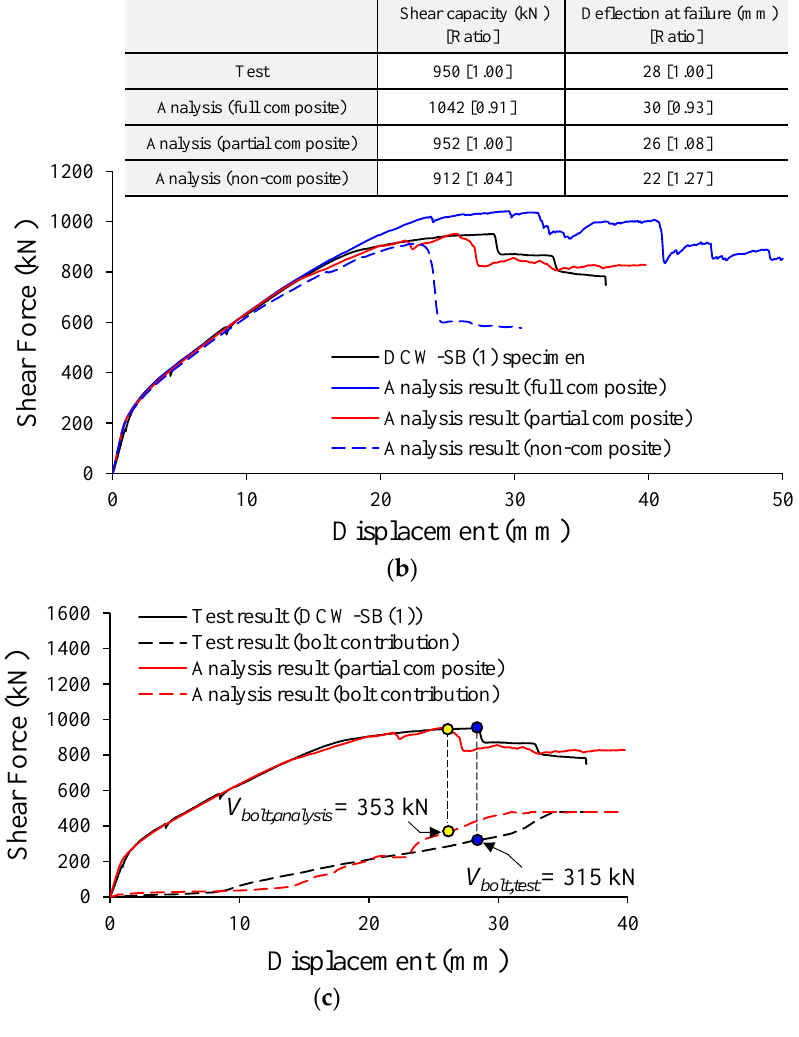
Figure 12. Comparison of the test and analysis results (DCW-S specimens): ( a ) DCW-SN specimen; ( b ) DCW-SB(1) specimen; ( c ) comparison of the bolt contributions in DCW.